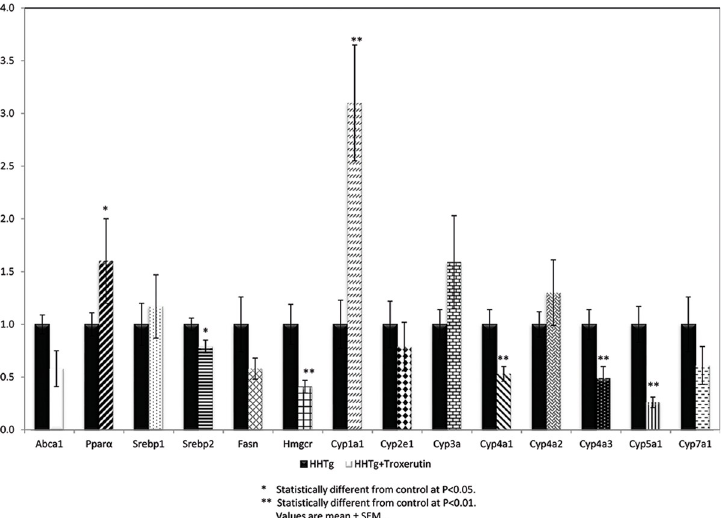
Fig 3. Hepatic gene expression of lipid metabolism and the cytochrome P450 system in HHTg rats treated with troxerutin compared to controls. Data are measured in triplets using n = 8 rats per group per analyses. Data are expressed as means (SEM) and analysed by two-tailed unpaired Student’s t test. � p < 0.05, �� p < 0.01.